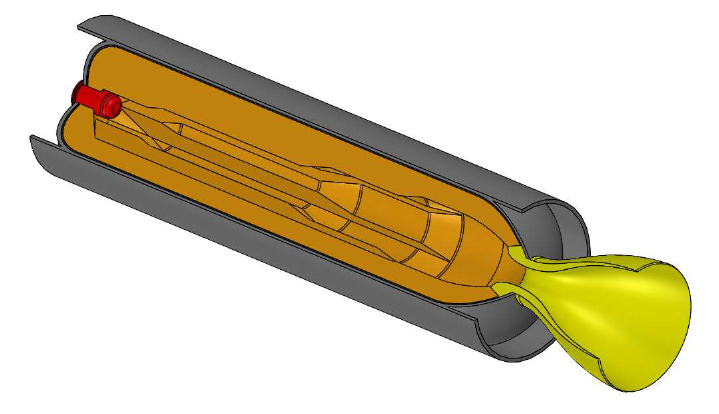
Figure 1. Scheme of a typical solid rocket motor: propellant grain (orange), igniter (red), insulation (black), motor case body (gray), and nozzle